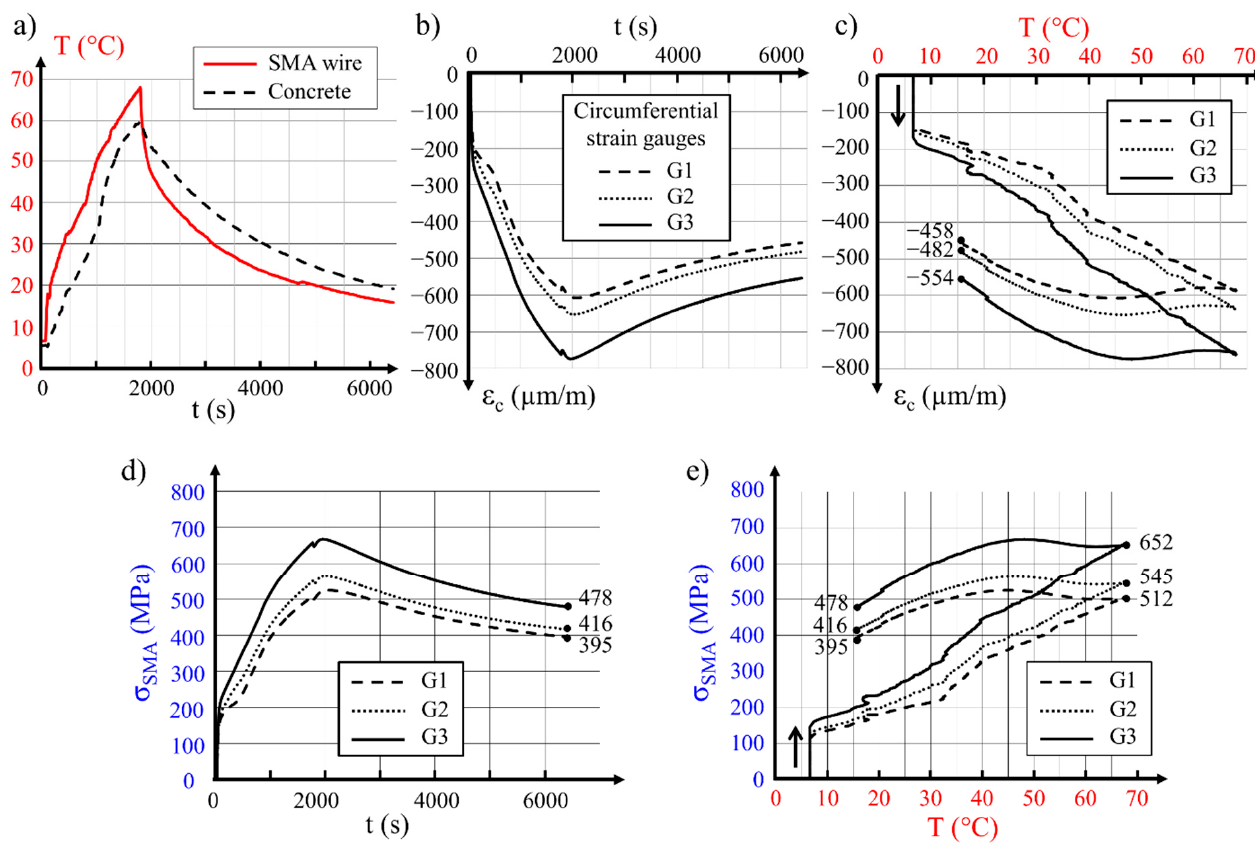
Figure 4. Results recorded during testing of the 300 mm hollow cylinder prestressed with predeformed 2 mm Ni–Ti wire: ( a ) temperature of the wire and the concrete surface over time; ( b ) variations of circumferential concrete strains over time; ( c ) variations of circumferential strain over concrete in relation to wire temperature; ( d ) stress in Ni–Ti wire in relation to time; ( e ) stress in Ni–Ti wire as a function of temperature.